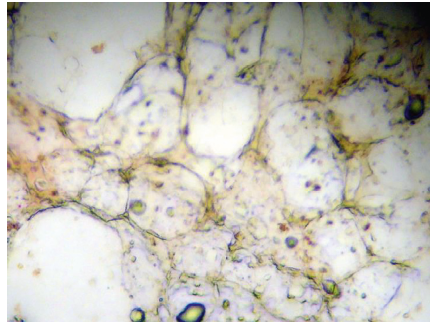
Figure 7: Bone marrow, negative for micrometastasis.